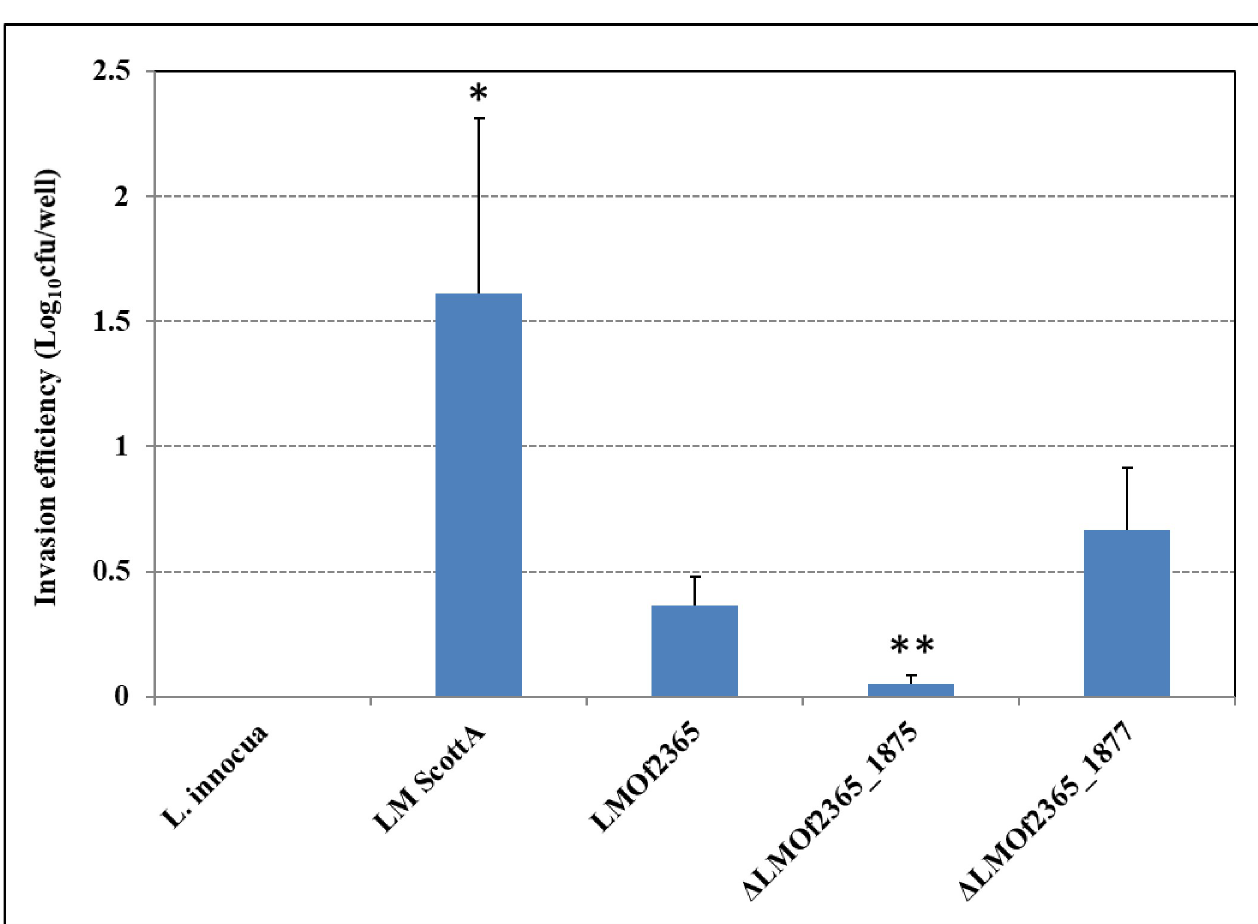
Fig 1. Invasion of Listeria strains in HT-29 cells. HT-29 cell monolayers were incubated with Listeria strains grown to stationary phase for invasion assays. Viable intracellular bacteria were counted after plating serial dilutions on BHI agar plates. The results were expressed as log numbers of CFU recovered relative to the number of bacterial cells (10 7 ) deposited per well. Each experiment was conducted in duplicate and repeated three times. Significant differences from parental wild type LMOf2365 strain are shown ( � , p-value < 0.05; �� , p-value < 0.01).